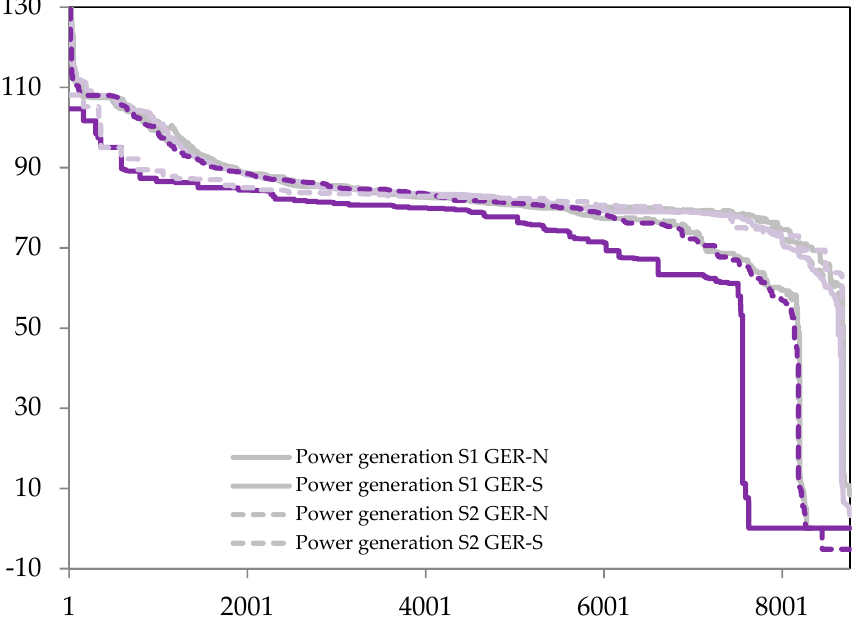
Figure A12. Duration curve of the marginal value of the battery balance equation (violet) compared to the load duration curve of the power generation marginal (grey). Solid lines show scenario S1 results and dashed lines scenario S2 results. Values for Southern Germany are given in light violet.